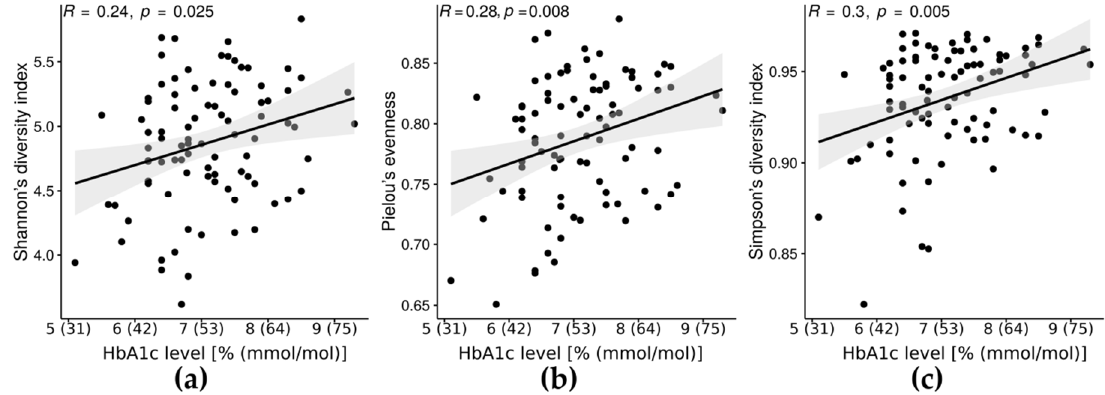
Figure 1. The relationships between glycosylated hemoglobin (HbA1c) level [% (mmol/mol)] and Shannon’s diversity index ( a ),Pielou’s evenness ( b ) and Simpsons`s diversity index ( c ).